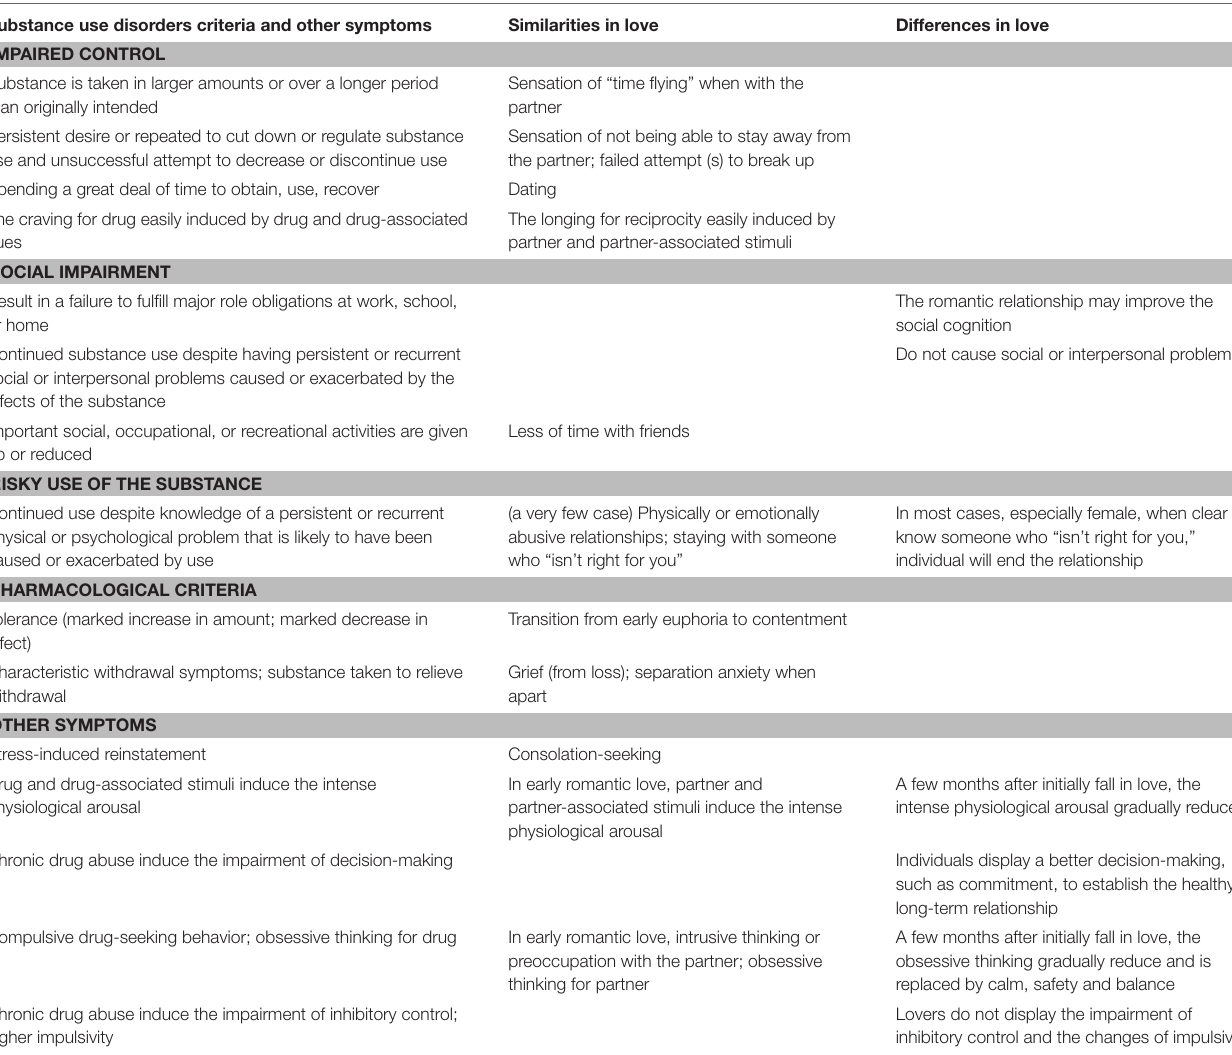
TABLE 1 | DSM-5 criteria and other characteristics of substance use disorders as compared to